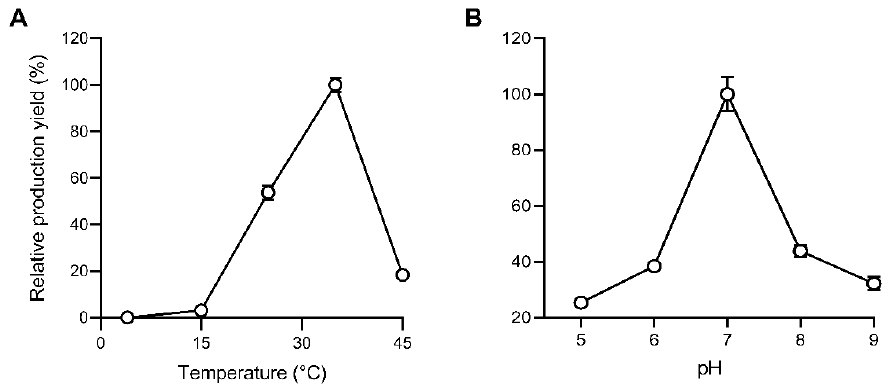
Figure 2. Effects of temperature ( A ) and pH ( B ) on the production of 1-octen-3-ol from linoleic acid by Ab LOX and Ab HPL.